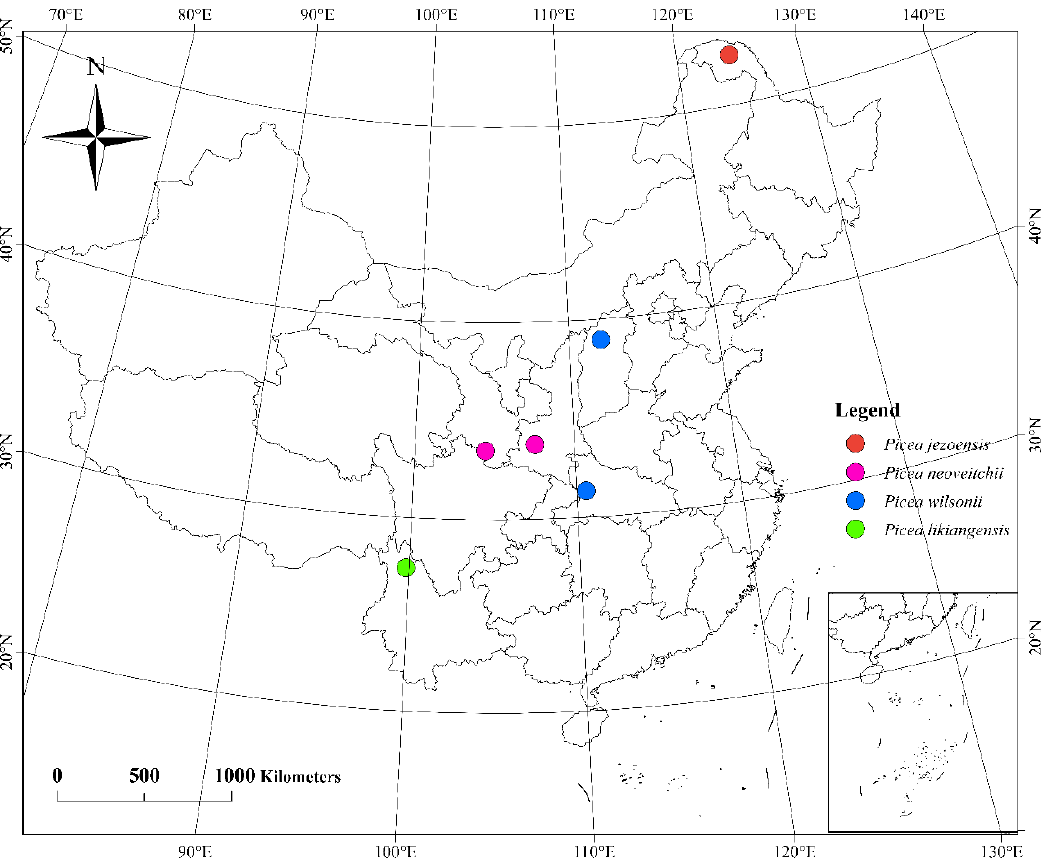
Figure 8. Sampling site map of 55 Picea plants in China.